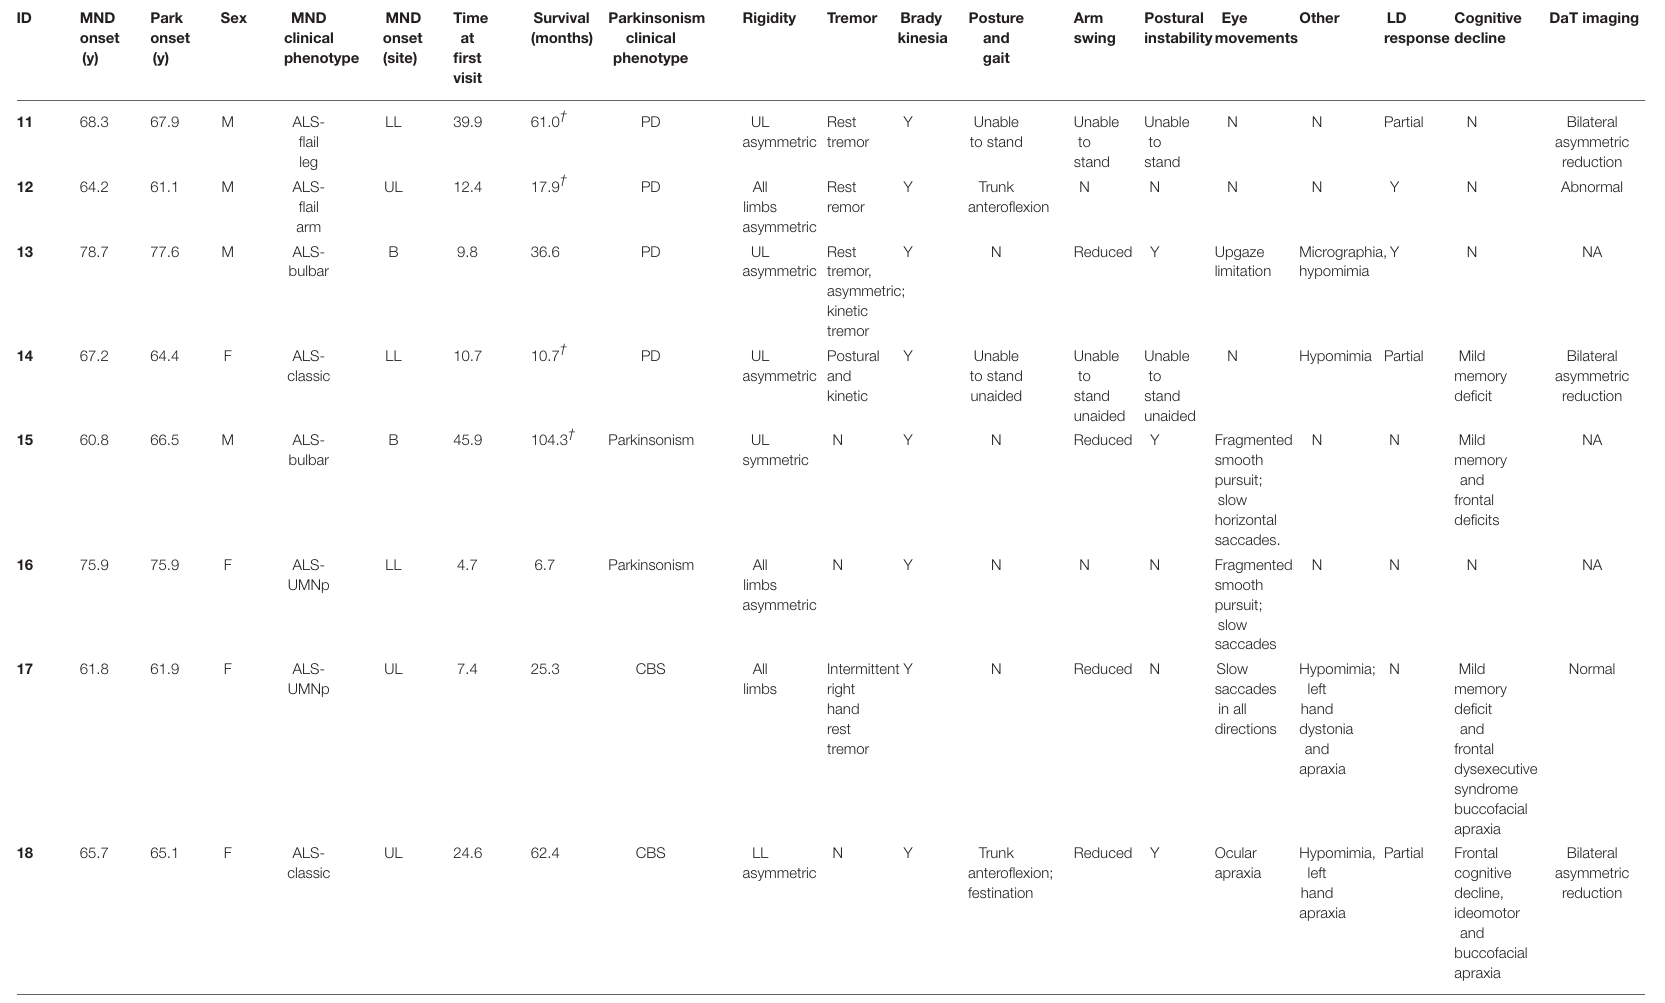
The table has been subdivided in two parts according to the following grouping: PLS-parkinsonism (IDs 1-7) and ALS-parkinsonism (IDs 8-18). Rigidity was considered to have parkinsonian characteristics when showing a clear cogwheeling phenomenon. Tremor was considered to have parkinsonian characteristics when showing a clear rest component. The presence of postural and kinetic is also reported. Bradykinesia was considered to have parkinsonian characteristics when showing a clear slowing and reduction of amplitude during finger tapping. Time at first visit is the disease duration expressed in months between onset of MND signs and symptoms and first evaluation at our Center. ALS, amyotrophic lateral sclerosis; B, bulbar; CBS, corticobasal syndrome; F, female; LL, lower limbs; M, male; N, no; NA, not available; Park, parkinsonism PD, Parkinson’s disease; PLS, Primary lateral sclerosis; PSP, progressive supranuclear palsy; UL, upper limbs; UMNp, upper motor neuron-predominant; Y, yes; y, years; † , alive or lost to